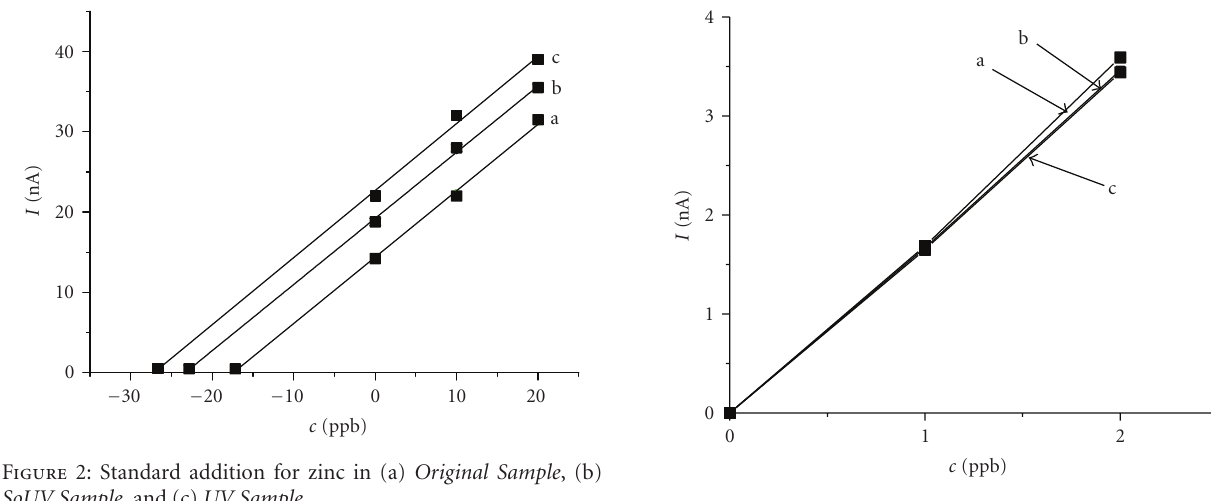
Figure 5: Calibration curve for cadmium in (a) Original Sample , (b) SoUV Sample , and (c) UV Sample .